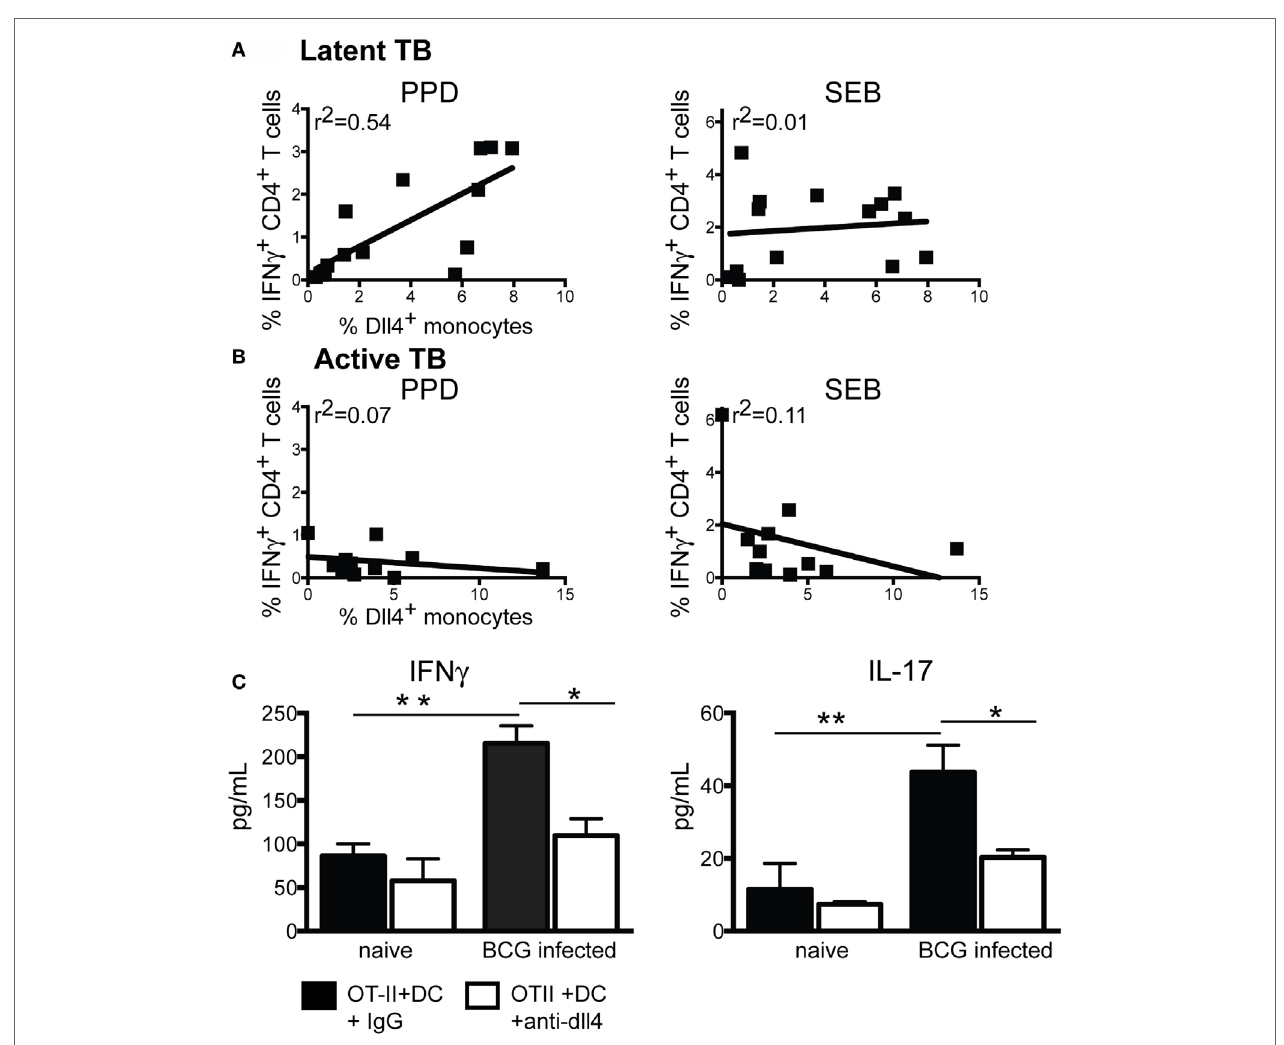
FigUre 4 | Delta-like 4 expression correlates with cytokine production from T cells during latent infection . (a) Linear regression analysis of CD4 + T cell IFN γ production, as measured by intracellular cytokine staining, compared to the percent of CD14 + monocytes expressing DLL4 in individuals diagnosed with latent Mtb infection. Similar results were obtained with IL-2 and TNF α production (Figure S4 in Supplementary Material). (B) Same comparison as (a) in individuals with active infection. (c) Production of IFN γ and IL-17 from murine OT-II cells cocultured with OVA peptide and splenic CD11c + CD11b + FACS sorted from the spleens of naïve mice or mice infected for 5 weeks with BCG in the presence of a polyclonal antibody specific to DLL4 or IgG control antibody. Cells were cultured for 72 h in the presence of 10 μ g/mL anti-DLL4 or control antibody. One-way ANOVA analysis indicated DLL4 was a significant factor in determining cytokine output from T cells. For IFN γ , the p value was < 0.0001, and for IL-17 the p value was